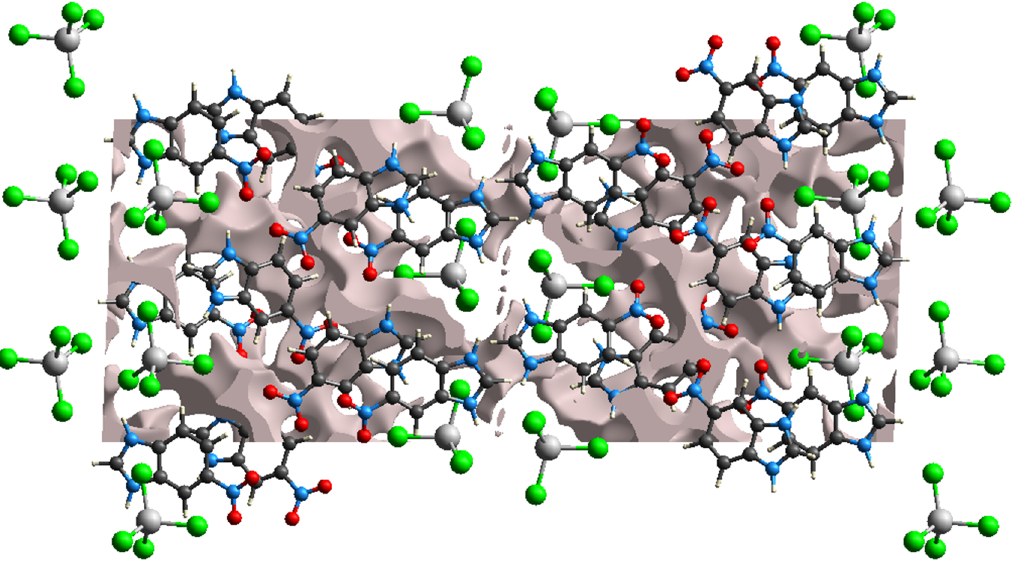
Figure 7. The projection along the b -axis showing the crystal voids in (C 7 H 6 N 3 O 2 ) 2 [ZnCl 4